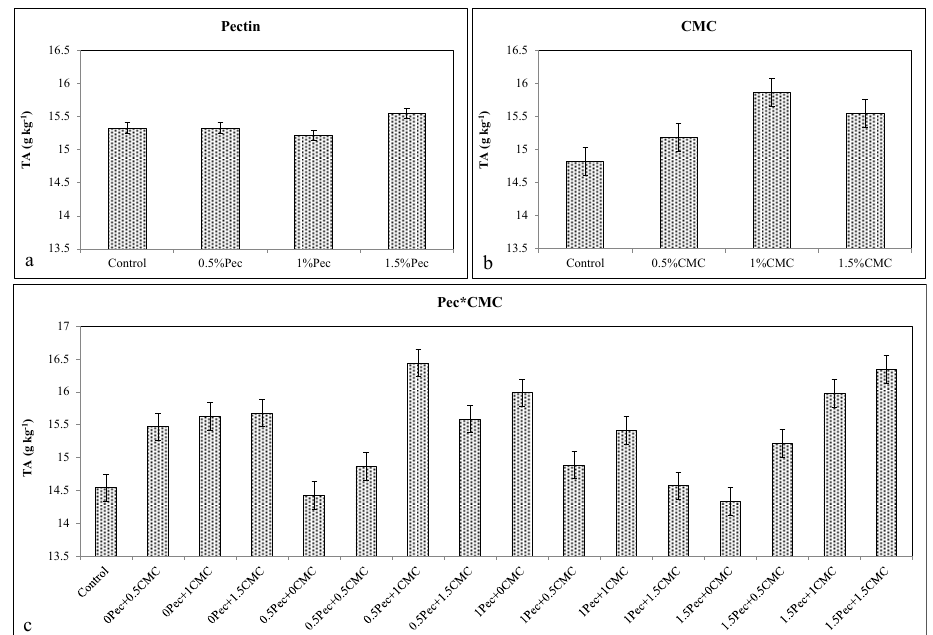
Figure 1. Effect of 0 (control), 0.5 (0.5% Pec), 1 (1% Pec) and 1.5 (1.5% Pec) % pectin-based edible coatings ( a ), 0 (control), 0.5 (0.5% CMC), 1 (1% CMC) and 1.5 (1.5% CMC) % carboxymethylcellulose- based edible coatings ( b ) and their combinations ( c ) on TA (titratable acidity) content during cold storage period. Data are the “estimated marginal means ±95% confidence intervals”. The results were expressed on a fresh weight basis. The columns with non-overlapping error bars are significantly different ( p ≤ 0.05).